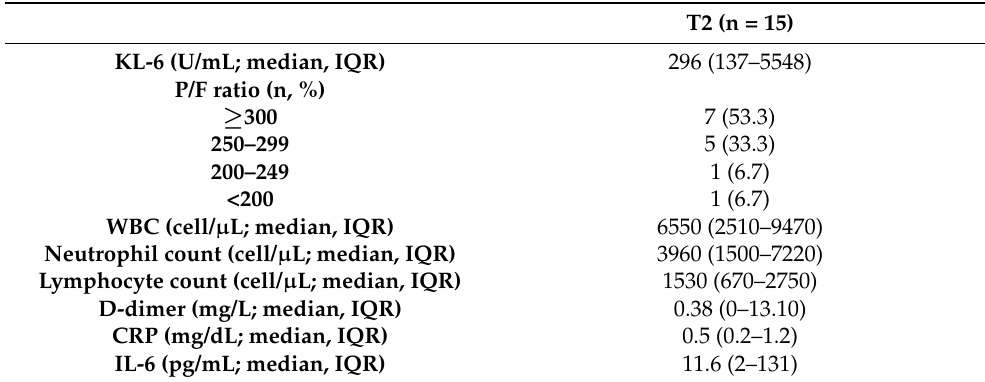
Table 3. Clinical and laboratory characteristics of the enrolled patients at the time of 14 days from enrolment—T2 (n =